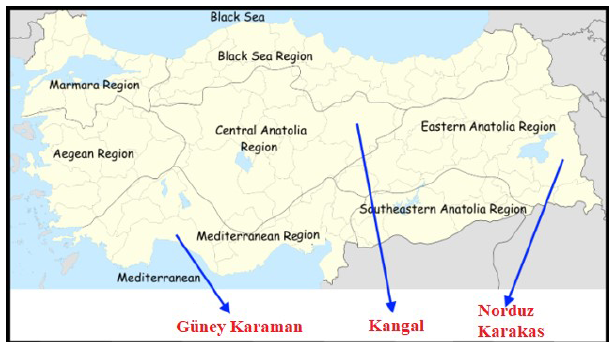
Figure 1. Geographical raising regions of four Turkish native sheep populations. Note: the base map of Turkey was downloaded from the web (https://tr.wikipedia.org/wiki/Dosya:Turkey_region_map_ with_province_borders.svg, last access: 9 June